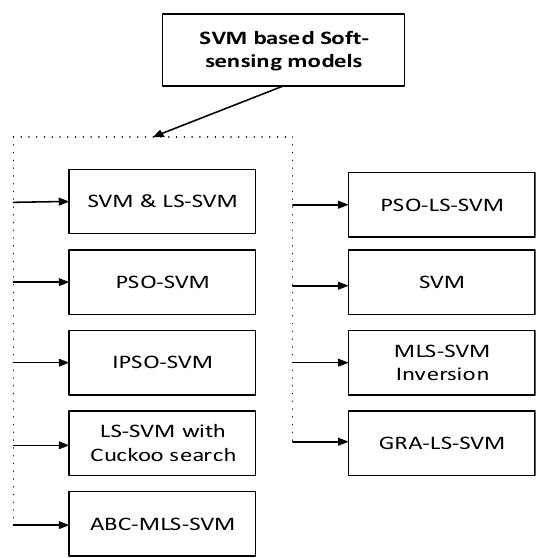
Figure 5. SVM based soft-sensing models (abbreviations are listed in Table A1).